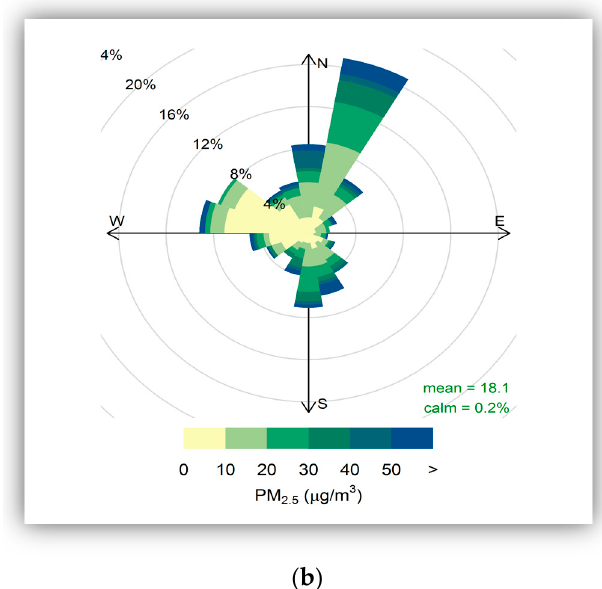
Figure 3. Denver near-road PM 2.5 increment and pollution rose. ( a ) Hourly (thin orange line) and 24-hr PM 2.5 concentrations (µg/m 3 , thick colored lines) at the near-road and nearby sites during February 2014, and the difference between 24-hr PM 2.5 concentrations (µg/m 3 ) at the near-road site and the nearby CAMP monitoring site (black line). ( b ) Pollution rose for hourly PM 2.5 concentrations (µg/m 3 ) at the Denver near-road site in February 2014. The size of each wedge indicates the frequency of wind direction. (For example, winds were out of the northeast nearly 25% of the time.) Color bands indicate the relative fraction of the time that concentrations occurred for each wind direction. For example, when winds were from the northeast, concentrations of 10–20 µg/m 3 were most frequent, followed by concentrations of 20–30 µg/m 3 .